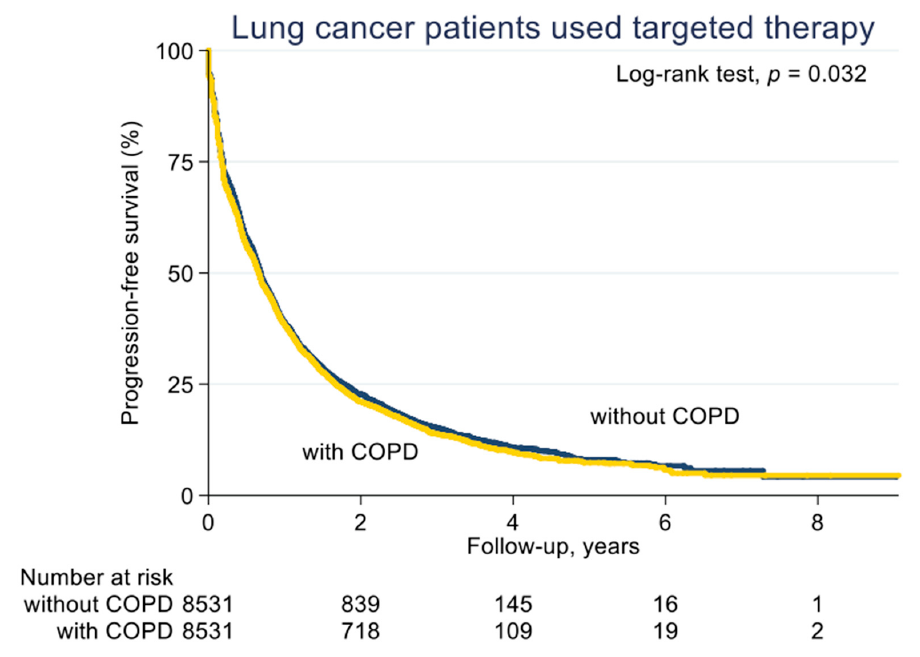
Figure 4. Progression-free survival curve of COPD and non-COPD cohorts (after PS matching).